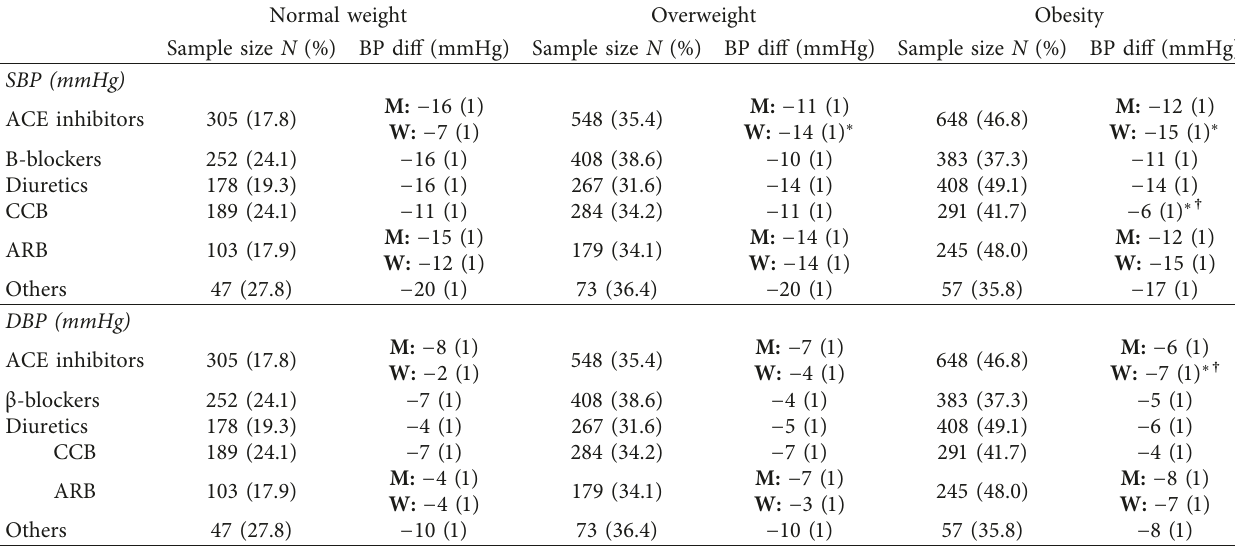
Table 2: Blood pressure differences between users and nonusers of individuals on antihypertensive monotherapy by BMI category. Normal weight Overweight